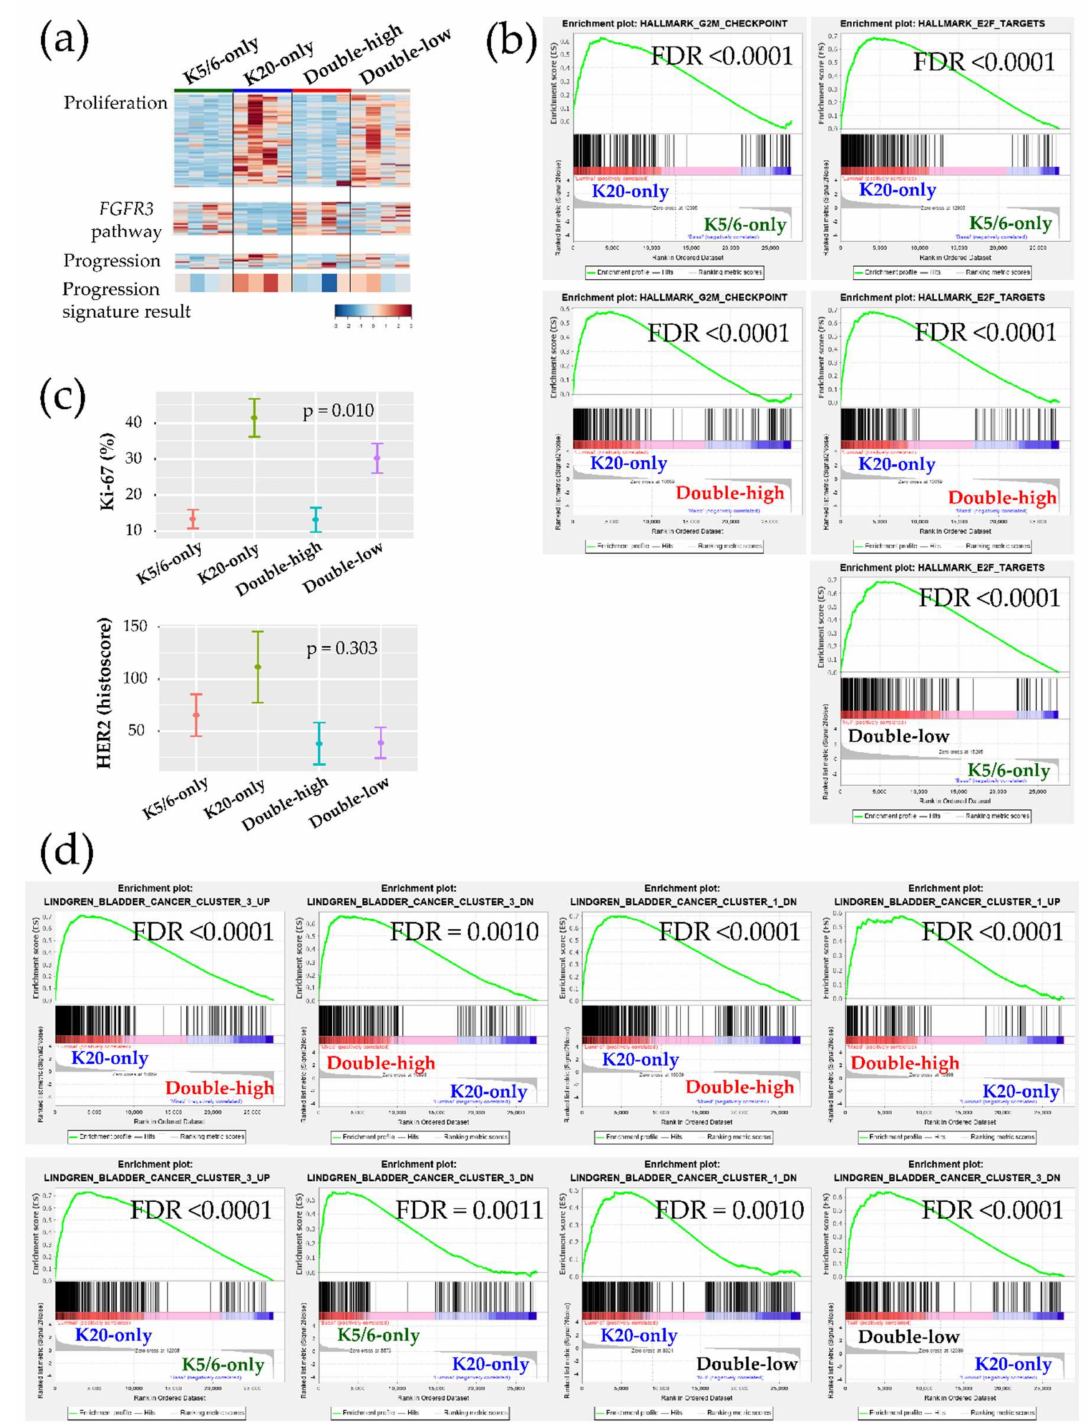
Figure 2. Biologic and functional signatures of the non-muscle-invasive bladder cancer (NMIBC) groups. ( a ) Heatmaps of genes included in the proliferation signature (top), the FGFR3 pathway (middle), and the progression signature (bottom). The progression result was obtained by subtracting the low-expression genes from the high-expression genes included in the NMIBC progression gene set. ( b ) Hallmark gene sets related to cell proliferation from the GSEA. ( c ) Immunohistochemical (IHC) staining results of Ki-67 (%) and HER2 (histoscore) for each group are illustrated as the mean (dot) and standard deviation (bar). ( d ) Curated gene sets from the GSEA (“Lindgren_bladder_cancer”) that were significantly enriched in the